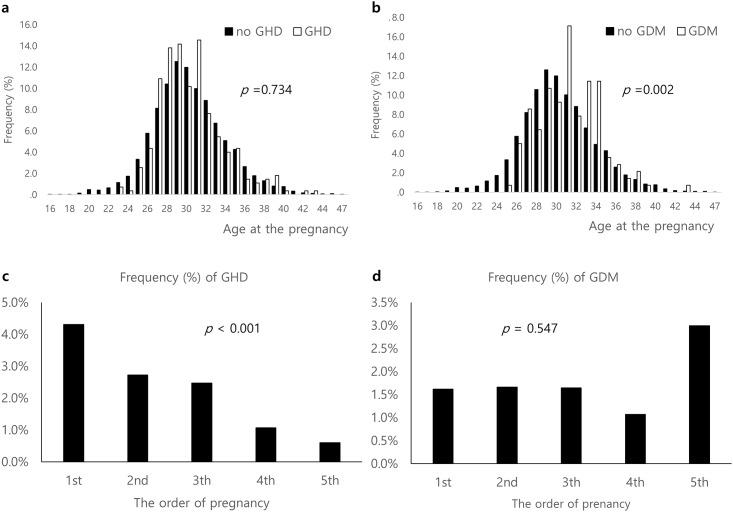
Distribution of age at every repeated pregnancy and frequency of GHD or GDM according to the order of pregnancy.(A) Histogram of age at the pregnancy in subjects with GHD or no GHD. (B) Histogram of age at the pregnancy in subjects with GDM or no GDM. (C) Incidence of GHD according to the order of pregnancy. (D) Incidence of GDM according to the order of pregnancy.